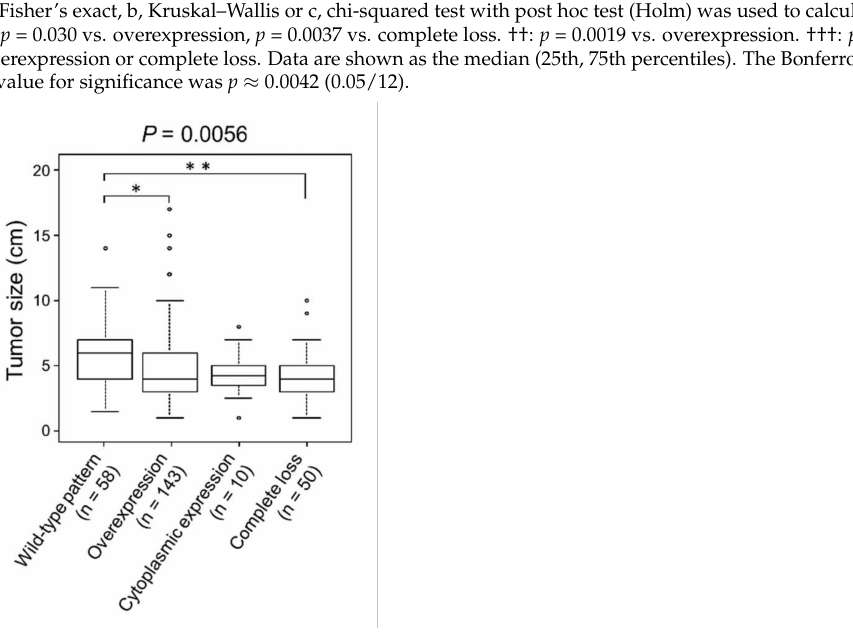
Figure 2. Association of p53 immunoreactivity and tumor size. CRCs with wild-type p53 expression showed significantly larger tumors than CRCs with p53 overexpression or complete loss. * p < 0.05; ** p <